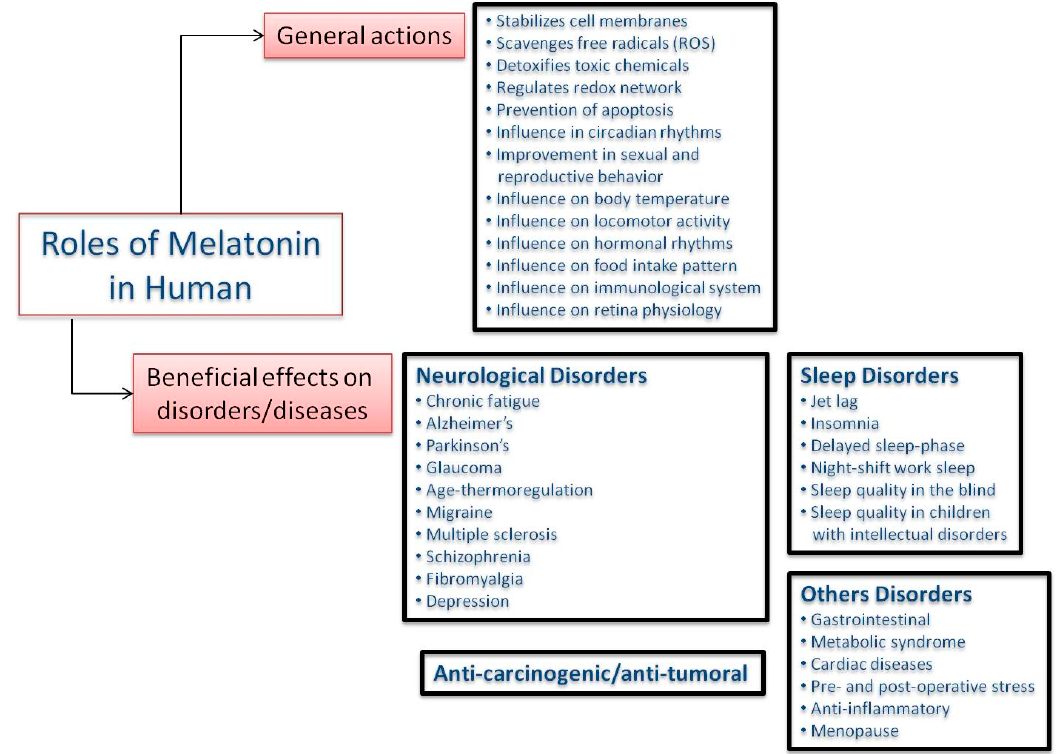
Figure 3. Roles of melatonin in human physiology.